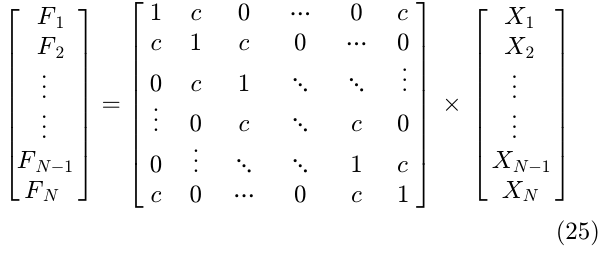
Figure 7. The line with squares represents the ball load distribution result calculated by the three-force ring superposition method, while the line with dots represents that by the static analysis model and the line with triangles represents that by the FEM simulation model in Xiong ’ s paper [12]. It can be seen from the fi gure that the result of three-force ring superposition method and is similar to that of the compared model. The maximal error between two numerical solutions is within 10%, which occurs around the major axis. And both of the number of no-load balls is 8.